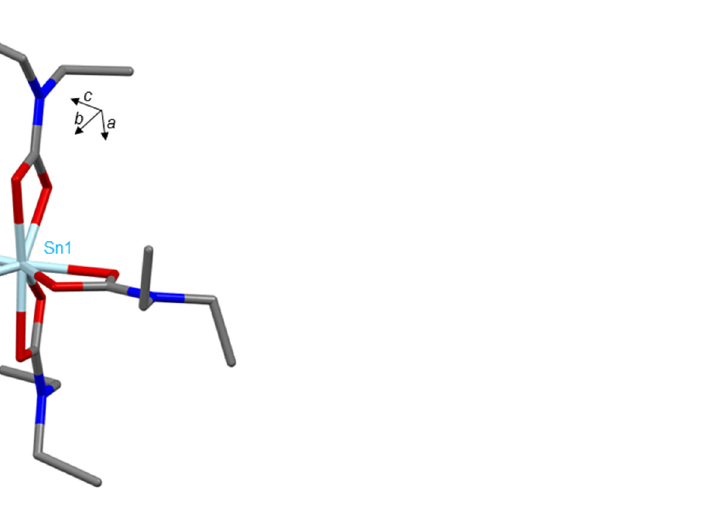
Figure 2. Molecular structure of 3 , adapted from [46] (MERCURY view). Hydrogen atoms are omitted for clarity (Sn light blue, O red, N dark blue, C grey).